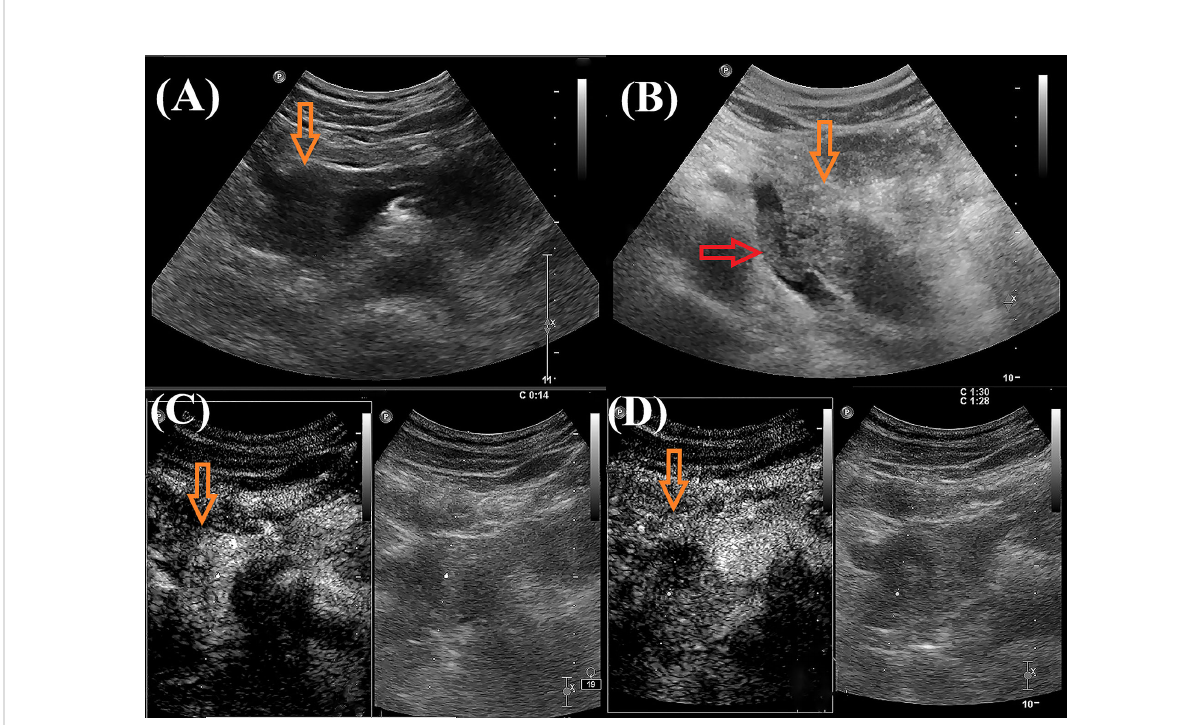
FIGURE 1 Ultrasound images of the patient. (A, B) : Grayscale ultrasound showed hypoechoic mass in the pancreatic parenchyma (orange arrow) and hypoechoic masses partially fi lled in the splenic vein (red arrow).In the arterial phase, contrast-enhanced US (CEUS) showed iso-enhancement to slight hypo-enhancement [ (C) , orange arrow)]; In the venous phase, CEUS showed hypo-enhancement [ (D) , orange